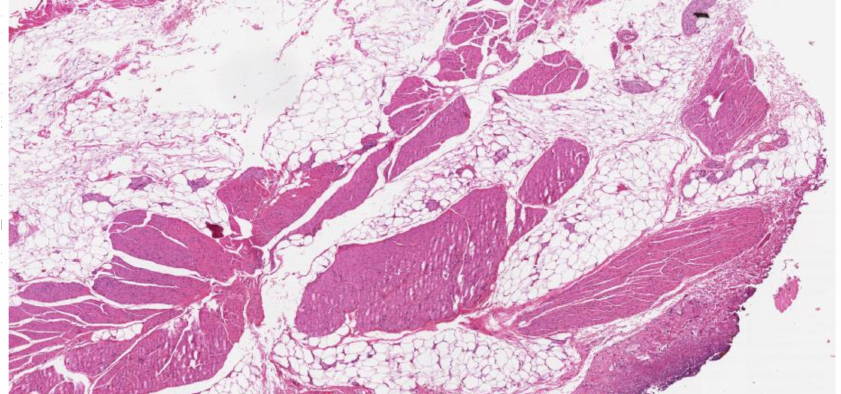
Figure 2. Abundant adipose tissue within the bladder wall, partially replacing the muscularis propria. 20 ×